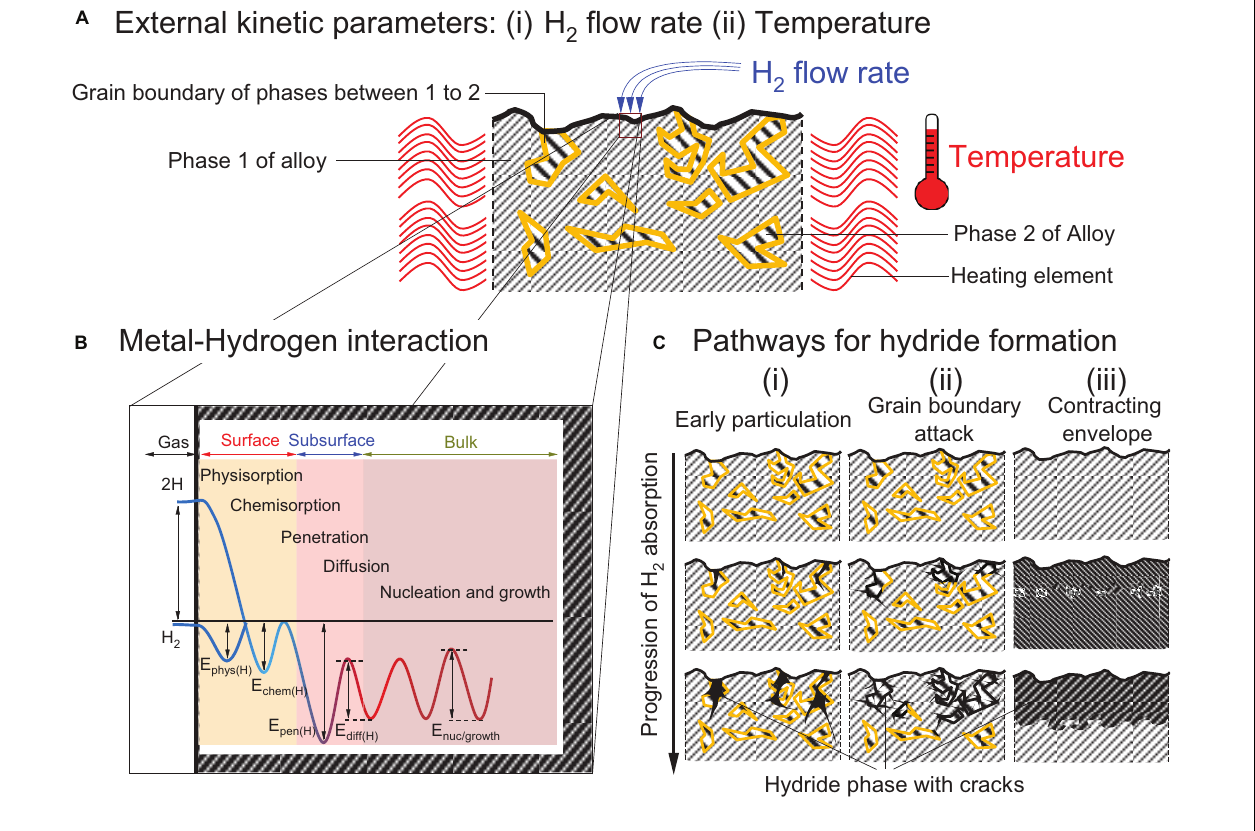
FIGURE 6 | Schematic illustrations of the factors that affect the limiting rate of reaction (A) Cross-section of the alloy that has two phases: phase 1 (color: gray) and phase 2 (color: yellow) before hydrogenation and being exposed to (i) H 2 gas and (ii) temperature variation. (Lee and Perng, 1991; Bloch and Mintz, 1997); (B) One-dimensional Lennard Jones potential curve of the reaction exposing the material to H 2 gas with postulated energy barriers for the hydrogenation of metal. (E represents an energy with subscript: phys(H), chem(H), pen(H), diff(H), and nuc/growth as H 2 physisorption, chemisorption, penetration in the subsurface, diffusion in bulk, and nucleation and growth of hydride phase, respectively.) (Lai et al., 2015), (C) Topochemical progression of metal hydrides (color: black) showing different pathways for hydride penetration: (i) Early particulation, (ii) Grain boundary attack, and (iii) Contracting envelope showing the progression of metal hydrides with cracks through phase 2, the grain boundary region between phase 1 and 2 and diffusing uniformly from metal surface, respectively (Mintz and Bloch, 1985; Lee and Perng, 1991; Bloch and Mintz,